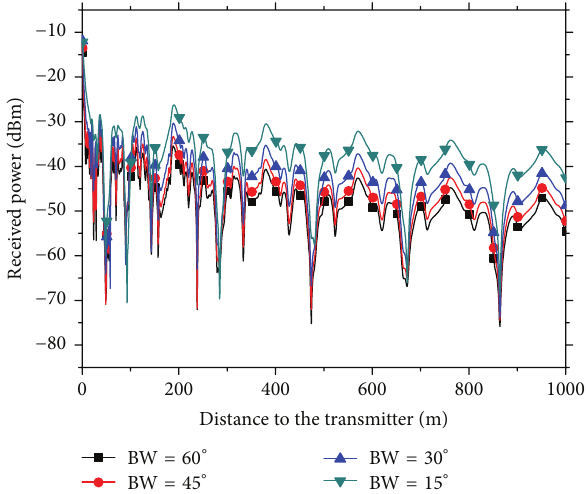
Figure6:Comparisonofthenumberoftheactivemodestestedwith different beam widths using the proposed modal method.